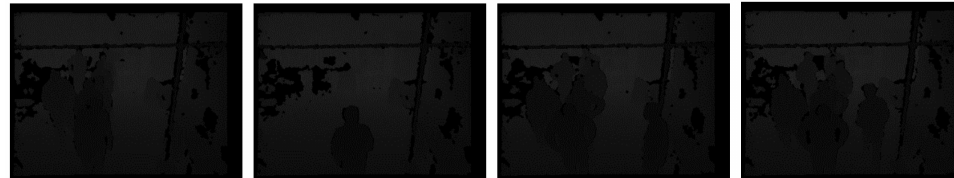
Figure 13. Some examples of the MICC people counting dataset.